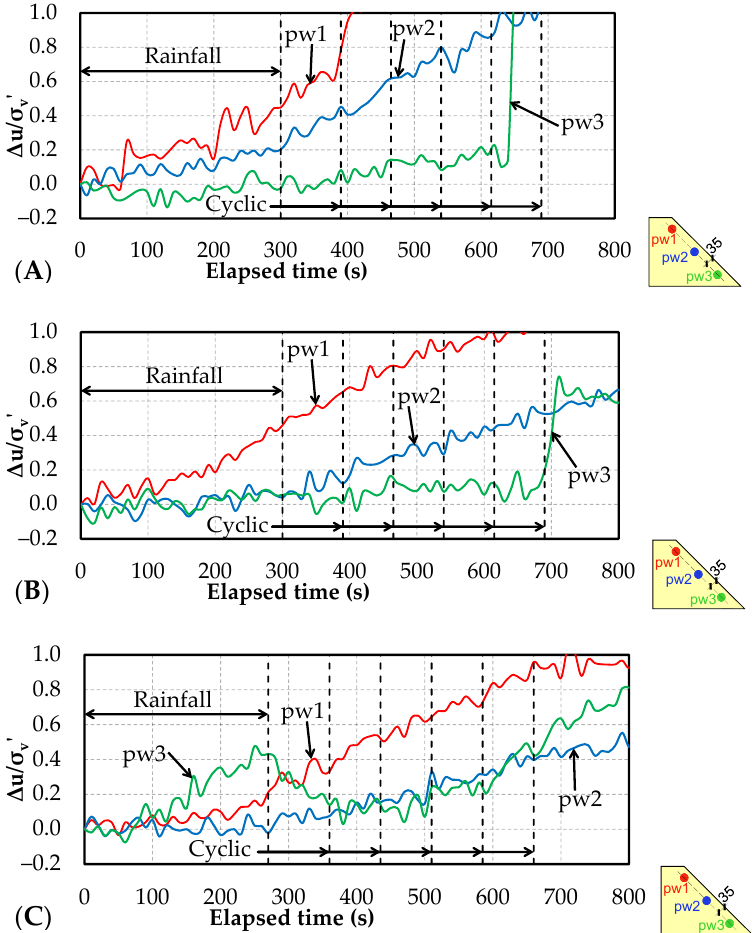
Figure 21. Changes in pore water pressure during post-rainfall earthquakes tests ( A ) K 8.5A, ( B ) K soil, ( C ) and K 40A .